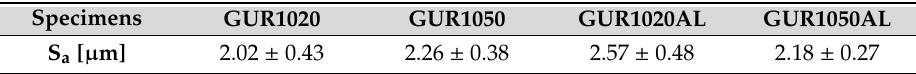
Table 3. Overview of the arithmetical mean height (S a ) of specimens (N =